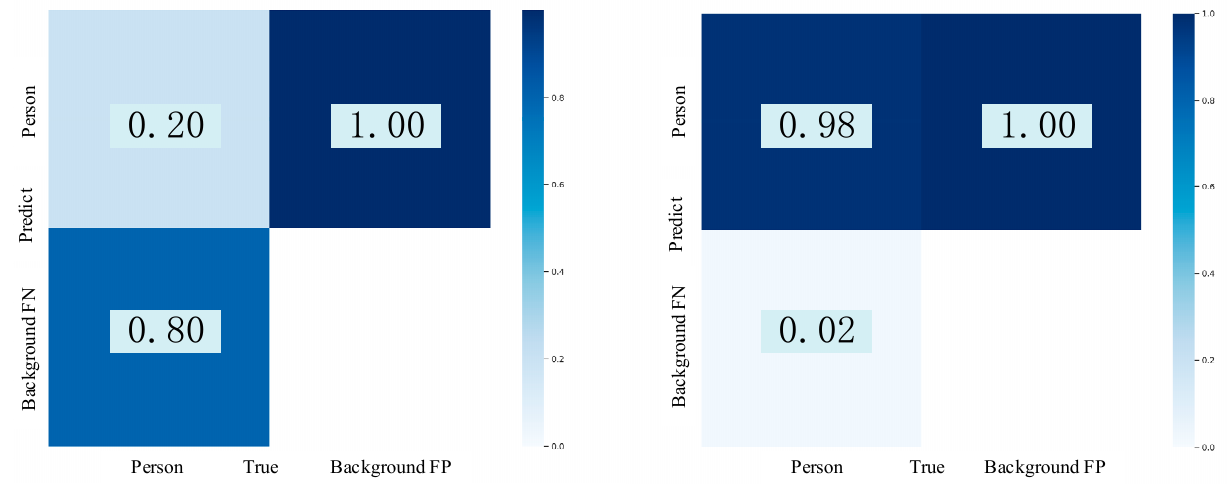
Figure 14. The confusion matrixes before and after the enhancement.